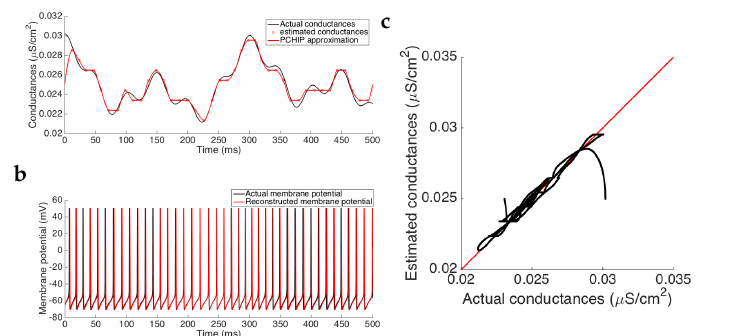
Figure 3. Results of the estimation procedure applied to a membrane potential generated through the pyramidal cell model with no additive noise, and using this same model as a base model in the estimation procedure . Panel ( a ) shows the prescribed conductances (black curve) and the estimated conductances (red curve). Panel ( b ) shows the membrane potential (black curve) obtained from the pyramidal cell model described in Section 2.1.1 and using the prescribed conductances of panel ( a ), and the reconstructed membrane potential (red curve) obtained also from the pyramidal cell model described in Section 2.1.1 but using the estimated conductances. Panel ( c ) shows the scatter plot of the prescribed conductances versus the estimated ones. The red line represents the identity line.